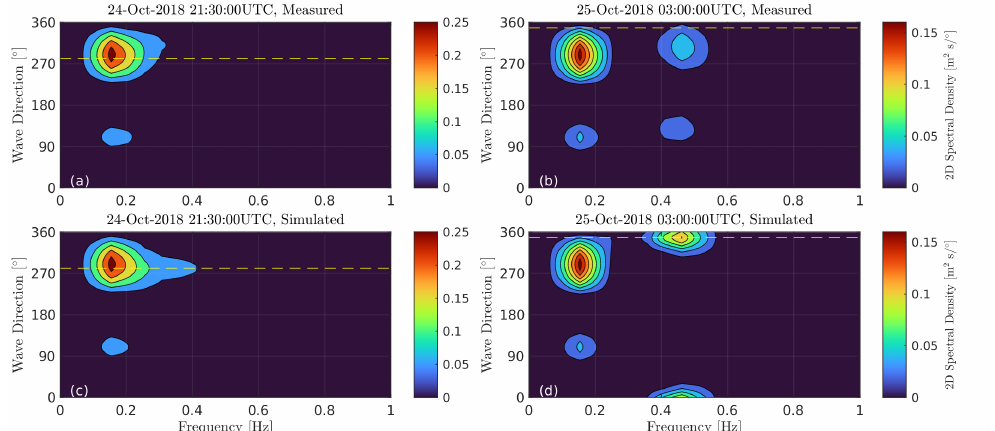
Figure 12. 2-D frequency-elevation spectra ( a , b ) measured by triangle wave gauge array and ( c , d ) sim- ulated by merging measured spectra ( f < 0.3 Hz) and JONSWAP model spectra [82] ( f > 0.3 Hz). Horizontal dashed lines show instantaneous wind